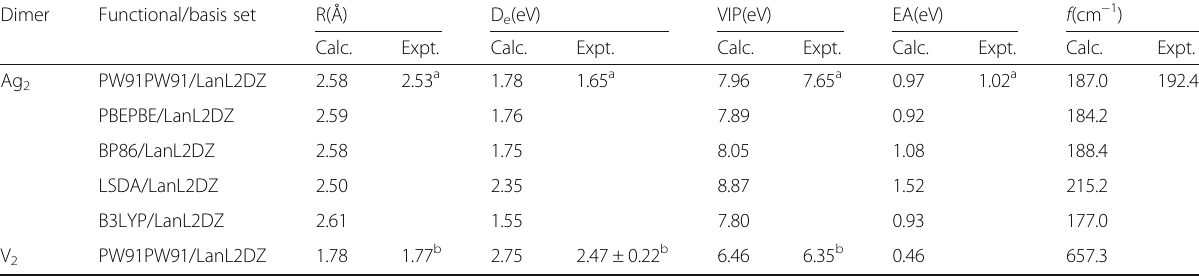
Table 1 The bond length and electronic properties of Ag 2 and V 2 dimers Dimer Functional/basis set